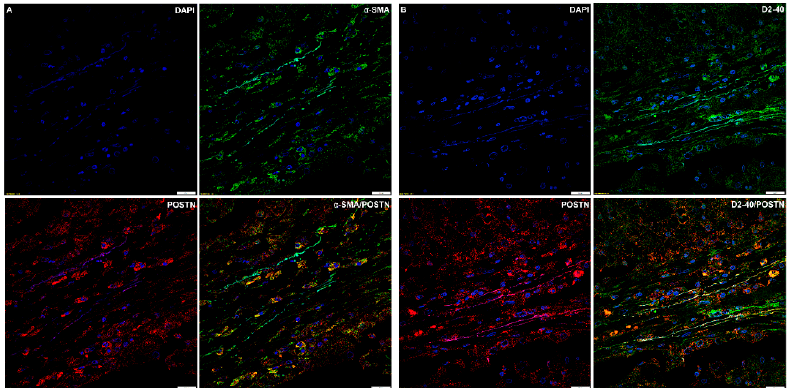
Figure 9. Confocal images showing colocalisation of ( A ) periostin (POSTN) / α -smooth muscle actin ( α -SMA) ( r = 0.37) and ( B ) periostin (POSTN)/podoplanin (D2-40) ( r = 0.28) in non-small cell lung carcinoma (NSCLC).. Objective 60×/1.40 Oil; pinhole airy 1.25. Bar = 20 µm.